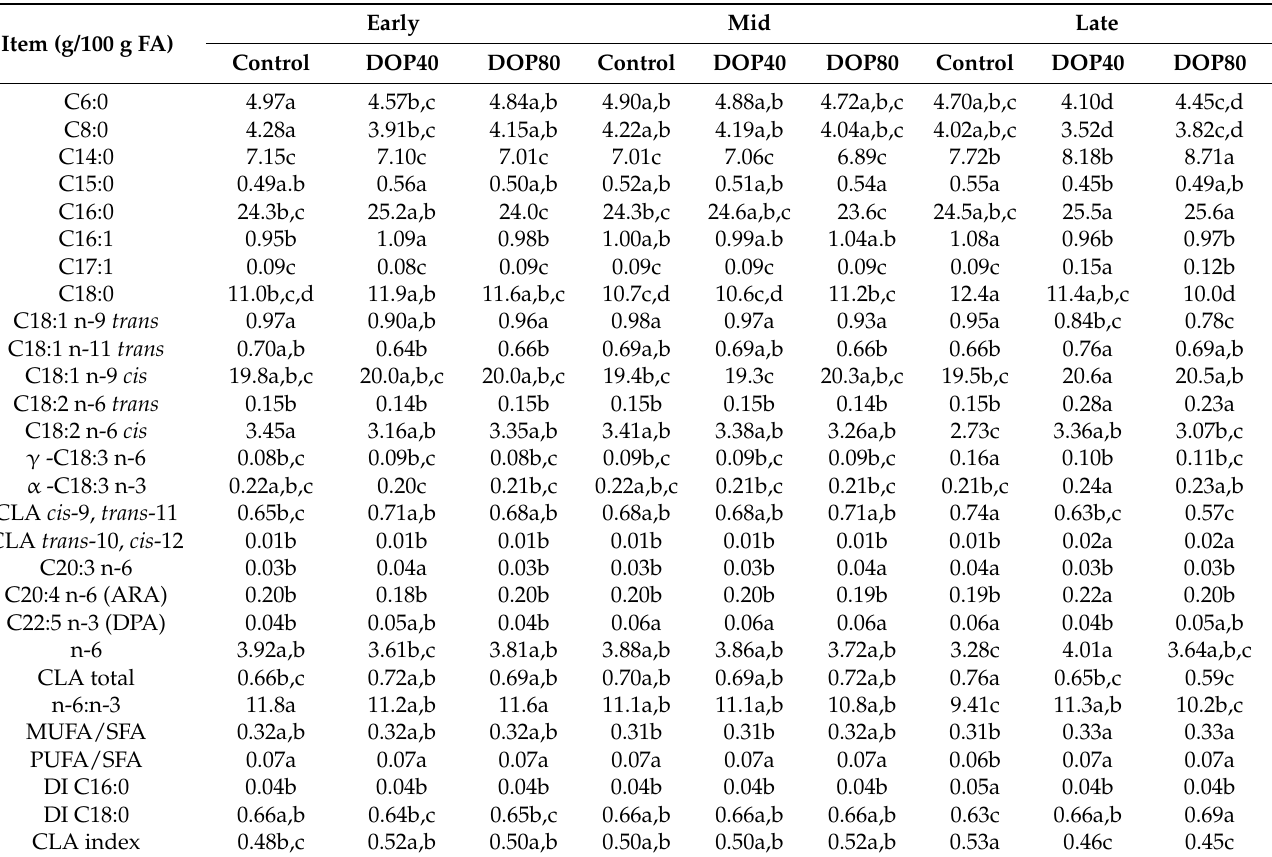
Table 4. Effect of interaction between dietary treatment 1 and lactation phase (early, mid, late) on the fatty acid (FA) composition of